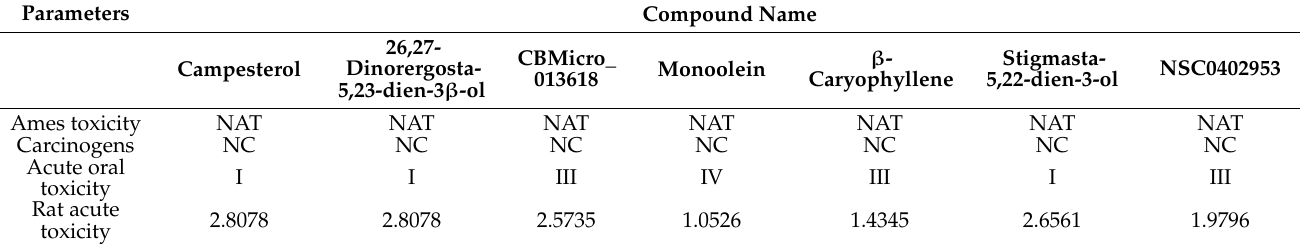
Table 8. Toxicological properties of seven key compounds in the